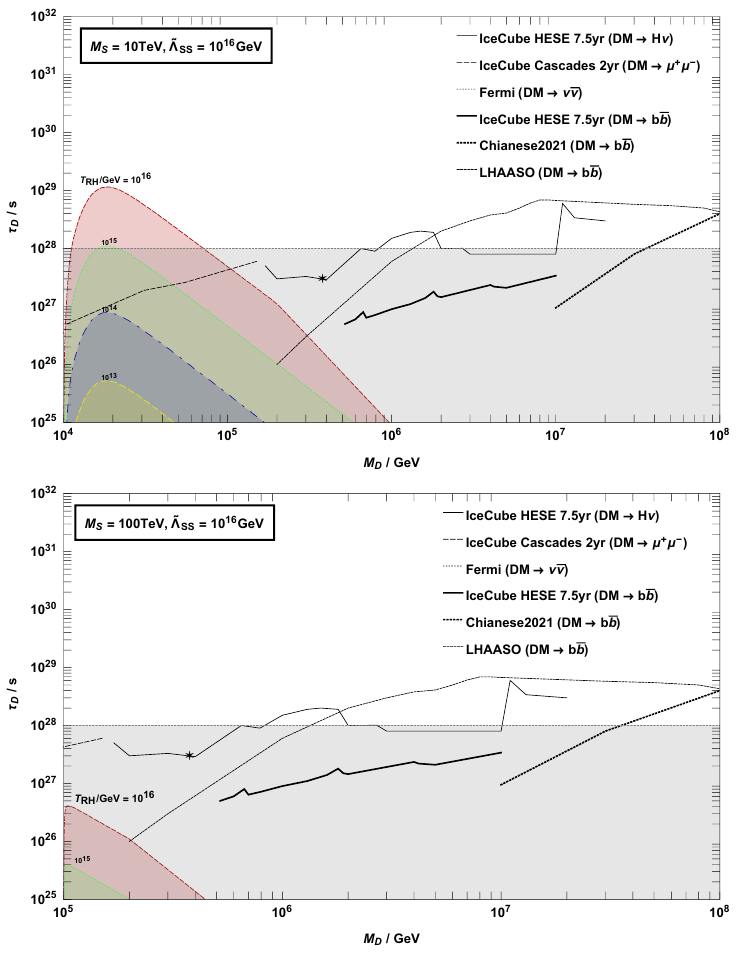
Figure 6 . Allowed regions in the lifetime versus mass plane for a fixed value ˜Λ SS = 10 16 GeV , for the indicated values of T RH and for M S = 10 TeV (upper panel), 100 TeV (bottom